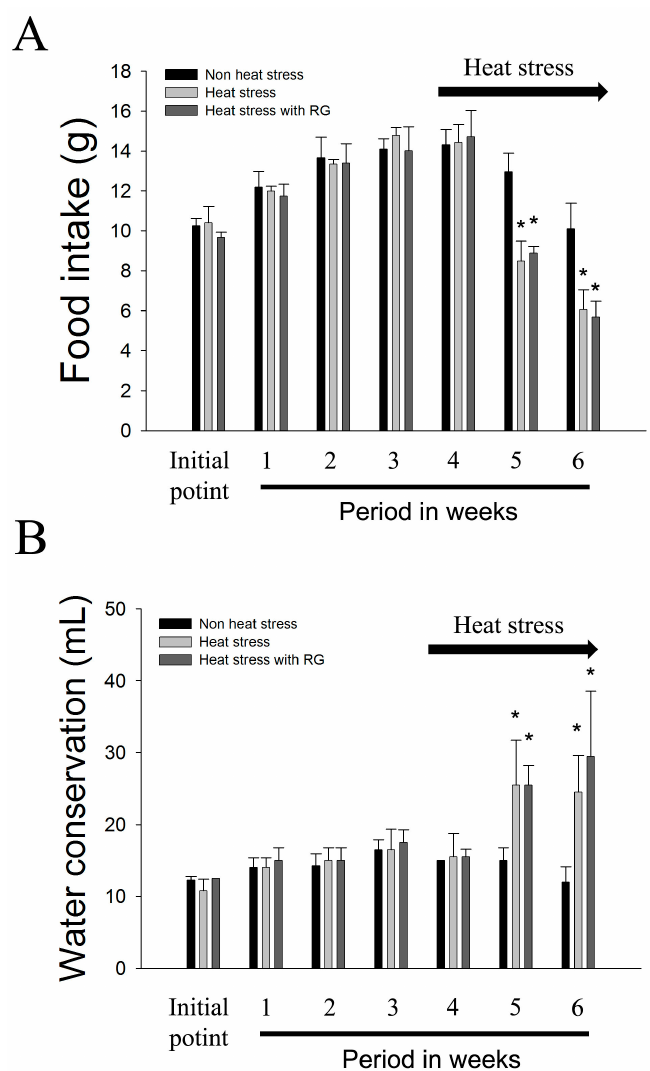
Figure 3. Mean of food intake and water conservation of SD rats housed under a normal environment for four weeks and with heat stress for two weeks. ( A ) Mean of food intake of SD rats; ( B ) Mean of water conservation of SD rats. The graph indicates control, heat stress, and heat stress with red ginseng extracts (RG) rats. The results are expressed as means ± standard deviation ( n = 8). * p < 0.05 compared with heat stress animals.